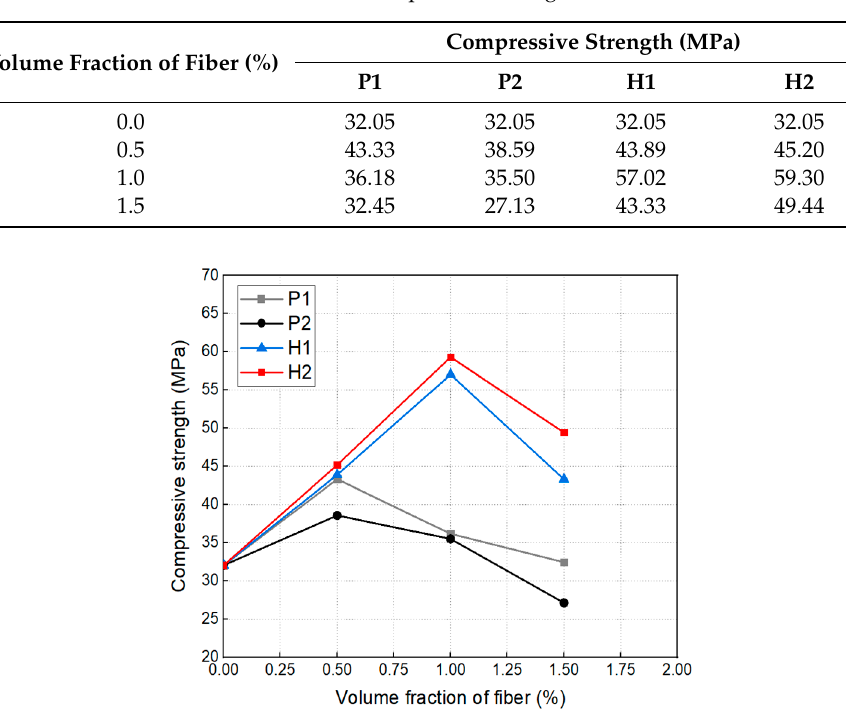
Figure 11. Compressive strength.